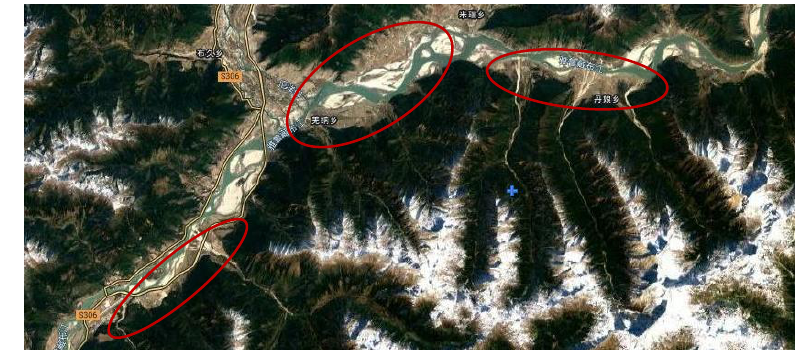
Figure 9 . The first river bends continuously.